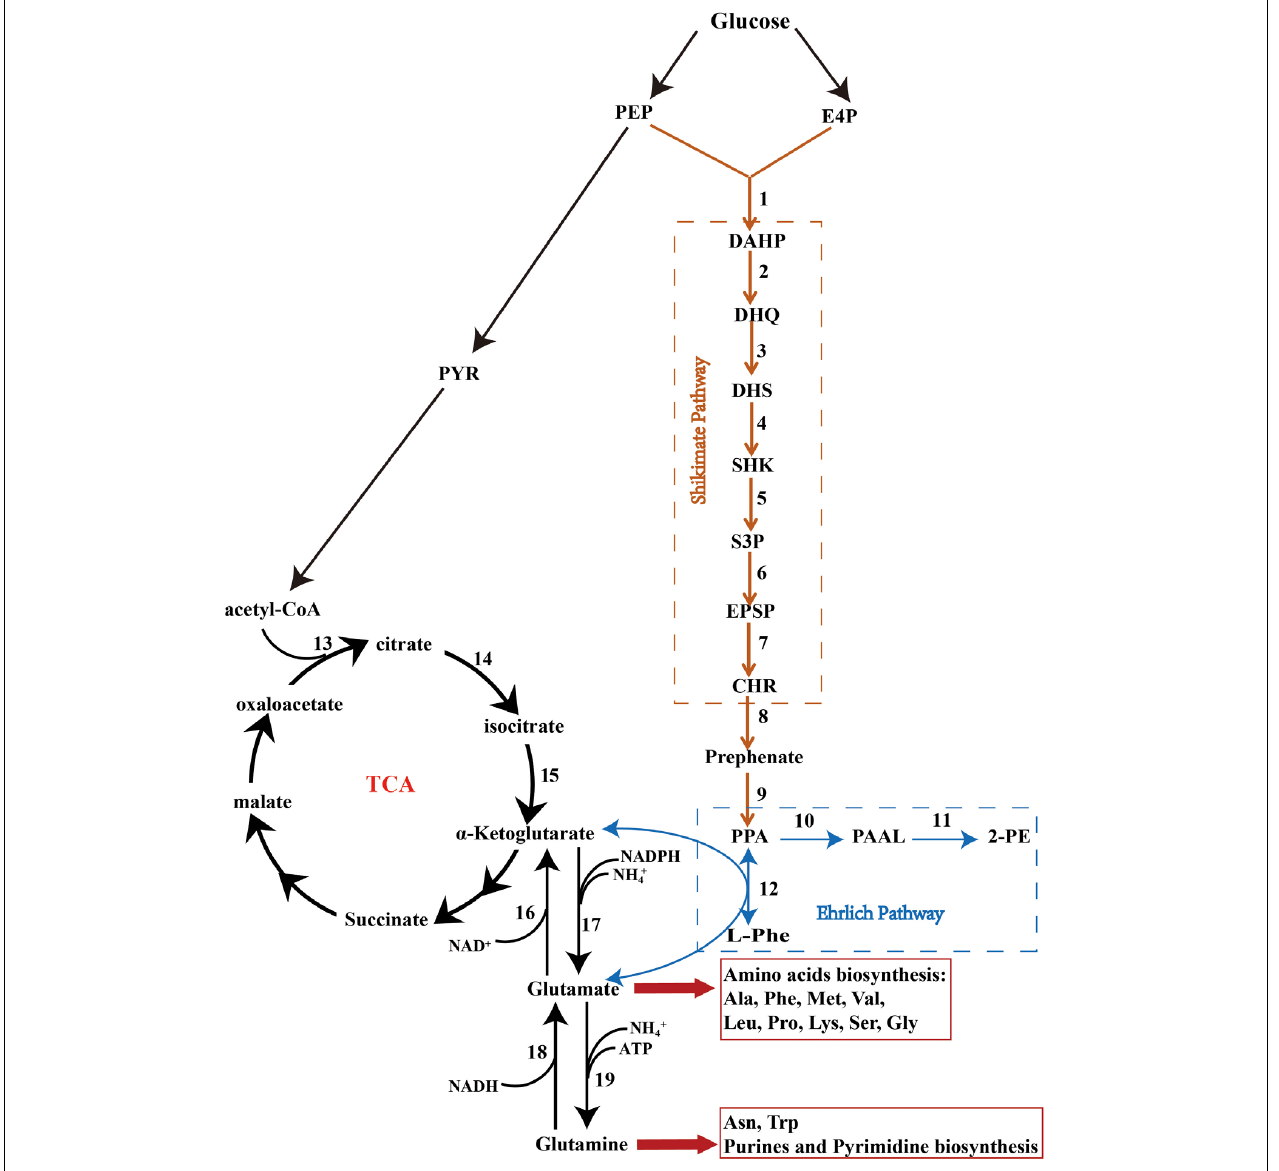
FIGURE 4 | The Shikimate, Ehrlich, and cinnamate pathways. PEP, phosphoenolpyruvate; PYR, pyruvate; E4P, erythrose-4-phosphate; DAHP, 3-deoxy- D -arabinoheptulosonate; DHQ, 3-dehydroquinate; DHS, 3-dehydroshikimate; SHK, shikimate; S3P, shikimate-3-phosphate; EPSP, 5-enolpyruvyshikimate-3-phosphate; CHR, chorismate; PPA, phenylpyruvate; PAAL, phenylacetaldehyde; 2-PE, 2-phenylethanol; L -Phe, L -phenylalanine; Ala, alanine; Phe, phenylalanine; Met, methionine; Val, valine; Leu, leucine; Pro, proline; Lys, lysine; Ser, serine; Gly, glycine; Asn, asparagine; Trp, tryptophan. The factors marked 1–19 are listed in Supplementary Table S3